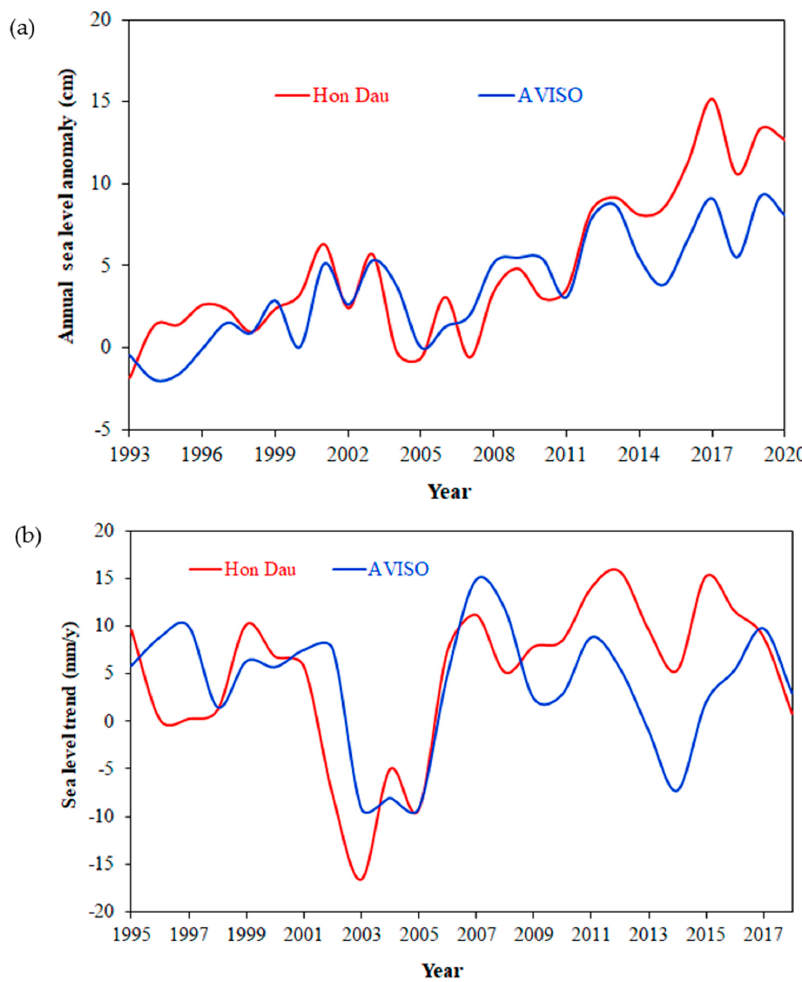
Figure 10. Comparison at tide gauge Hon Dau and satellite altimetry data: ( a )—SLA; ( b )—sea level rise calculated over five-year-long moving windows.